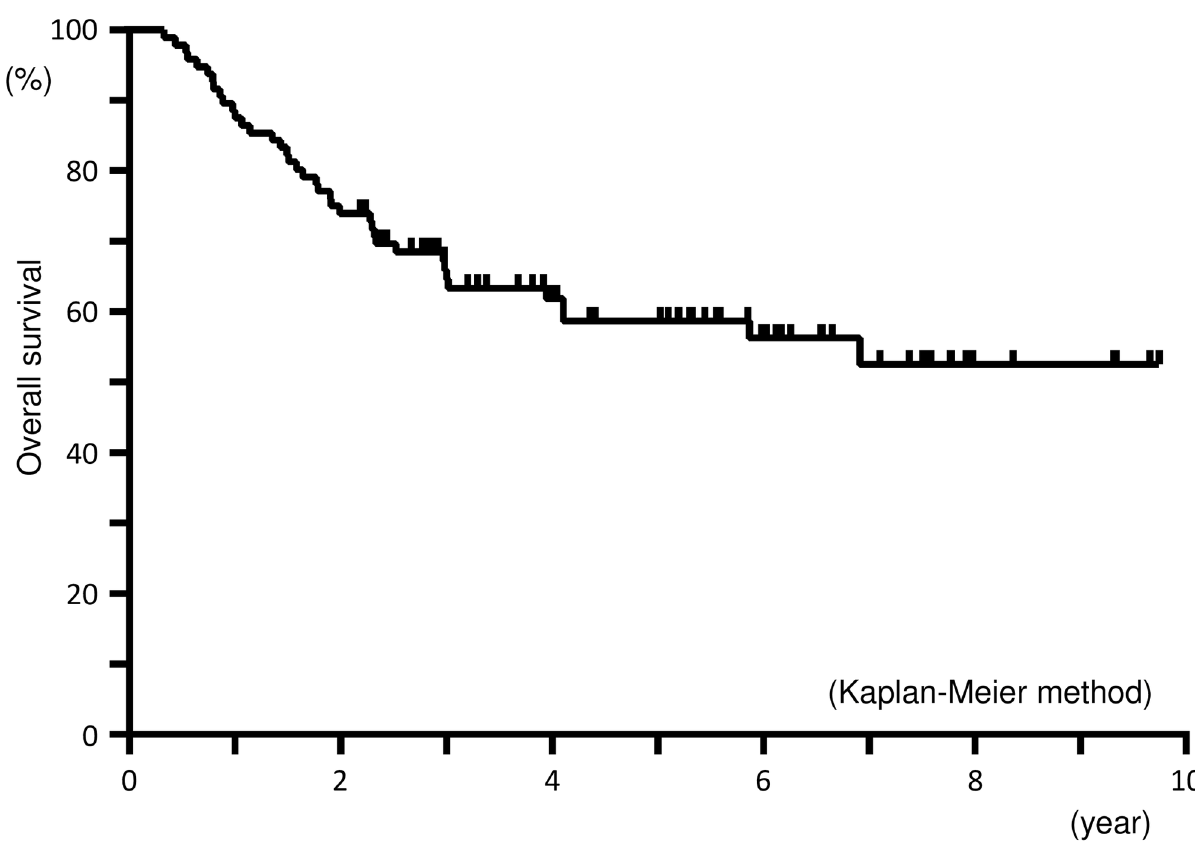
Fig 1. Overall survival for all patients. The 2-year and 5-year overall survival rates were 74.0% and 58.7%,